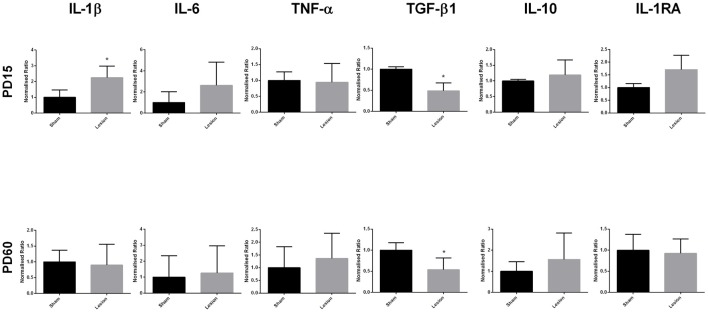
Levels of expression of pro- and anti-inflammatory cytokines from sham and NVHL animals from medial prefrontal cortex (mPFC) at PD15 and PD60. Quantification of Q-RTPCR data (normalized ratio of gene of interest over housekeeping gene); genes of interest quantified include interleukin-1β (IL-1β), interleukin-6 (IL-6), tumor necrosis factor-α (TNF-α), transforming growth factor-β1 (TGF-β1), interleukin-10 (IL-10) and interleukin-1RA (IL-1RA) at two developmental time points PD15 and PD60. Expression of IL-1β was found to be significantly increased in the NVHL groups as compared to the sham group at PD15 (*p = 0.0019). Decreased expression of TGF-β1 was observed in the NVHL group as compared to sham group both at PD15 (*p = 0.0291) and PD60 (*p = 0.0064). No significant change in the expression of IL-6, TNF-α, IL-10, IL-1RA was observed between sham and lesion group at PD15 and PD60 (n = 4–8 per group).